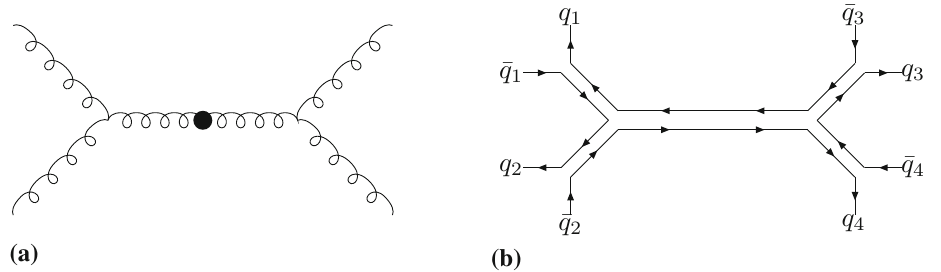
Fig. 6 Example of colour-singlet gluon pair production followed by the branching of all the colours via g → gg . The Feynman diagram is shown in a whereas the colour flows, including the non-perturbative splitting of the gluons into quark–antiquark pairs, are shown in